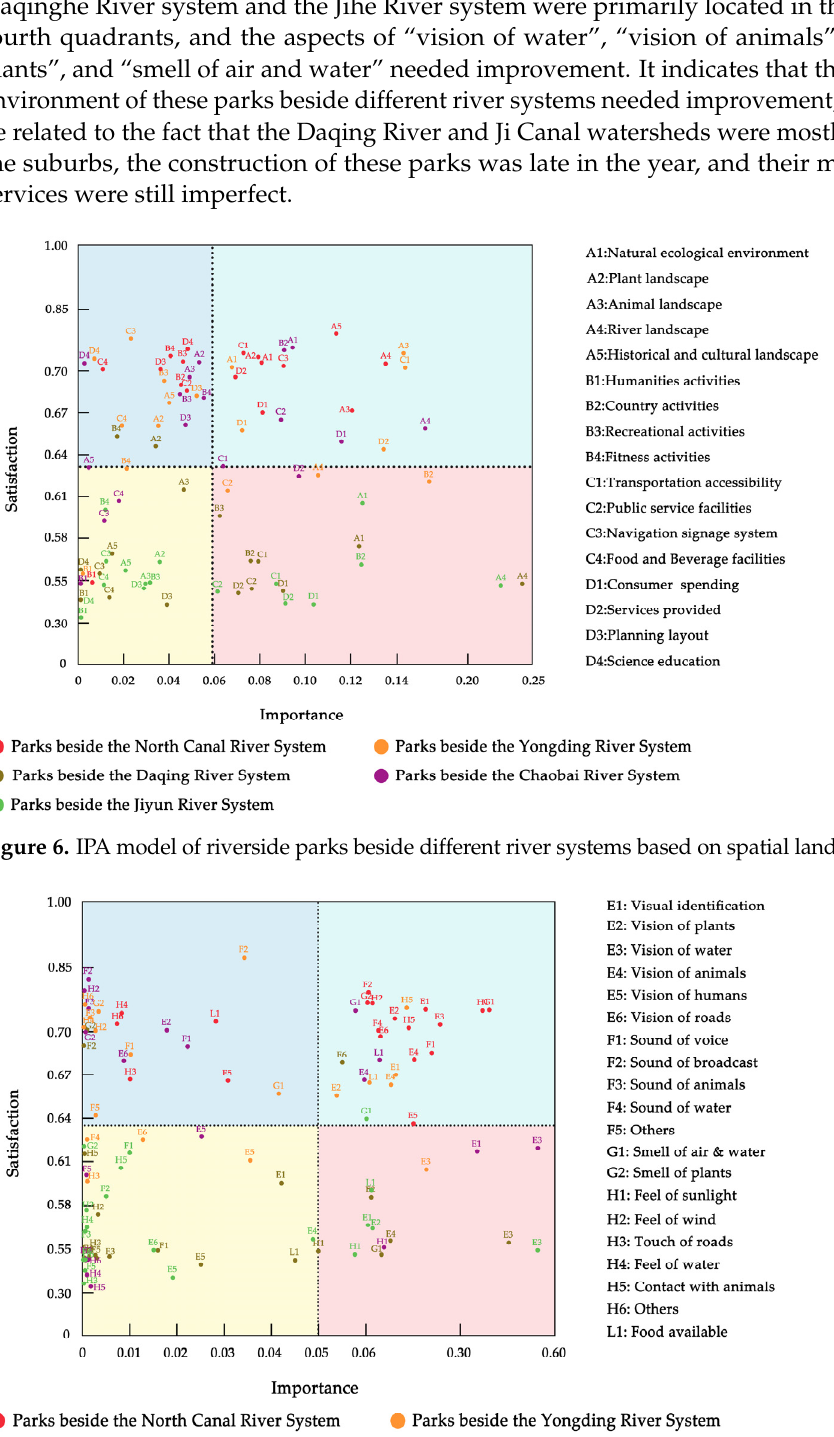
Figure 7. IPA model of riverside parks beside different river systems based on visitors’ sensory perception.